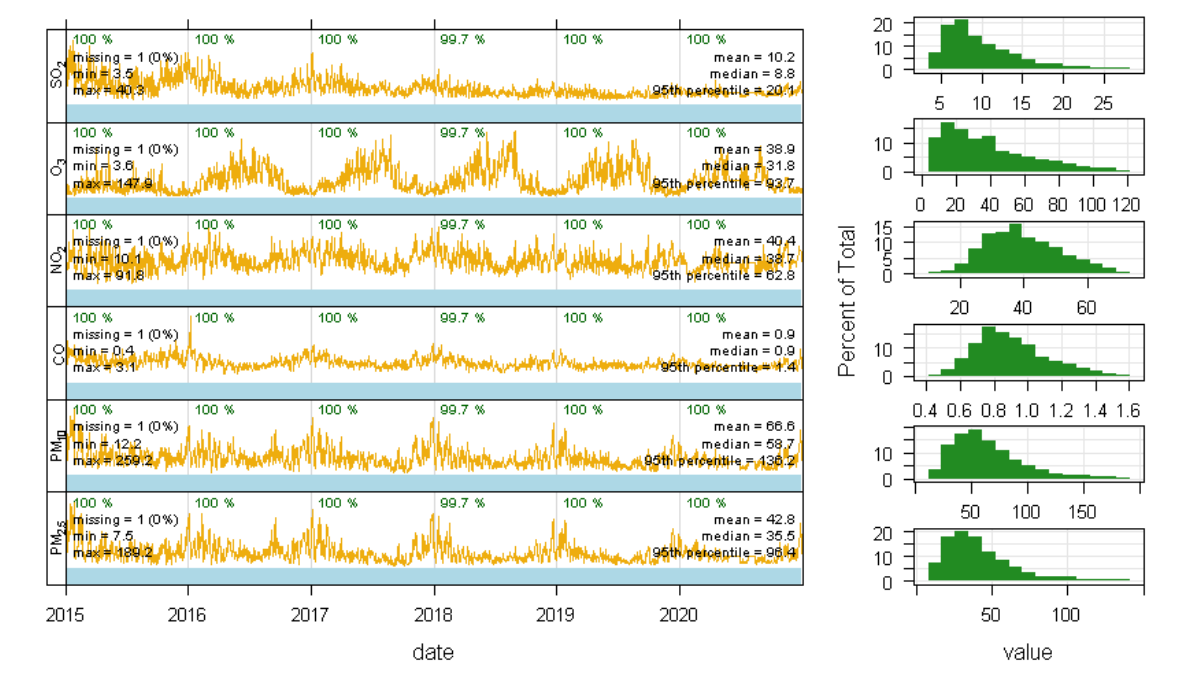
Figure 2. The plots in the left panel show the time series data. The daily mean values are shown in pale yellow scaled to cover the range in the data from zero to maximum daily value. The panels on the right show the distribution of each species using a histogram plot.